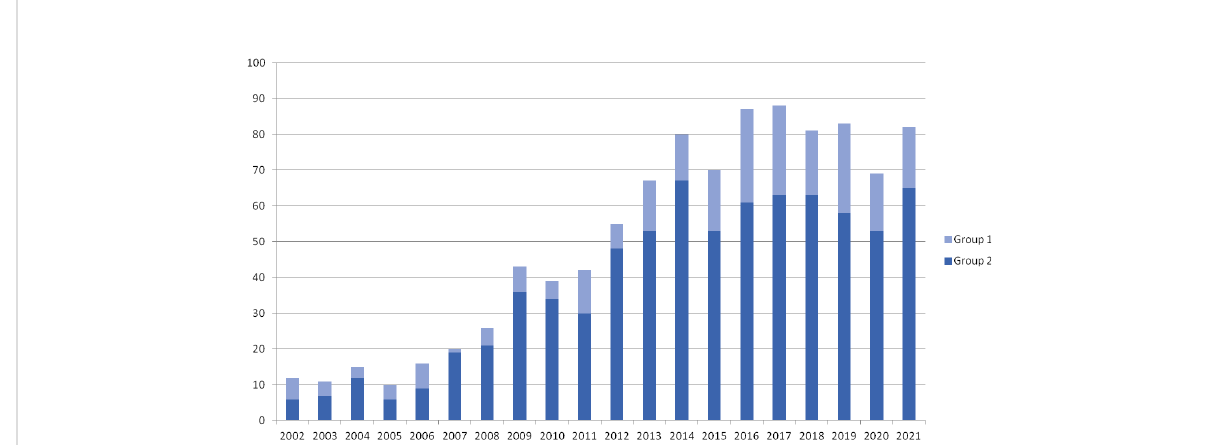
FIGURE 1 Ovarian tissue cryopreservation per year. Representative histogram of cryopreservations performed in Group 1 (pediatric girls, ≤ 17 years) and Group 2 (adult women, range 18-38 years) per year from 2002 to